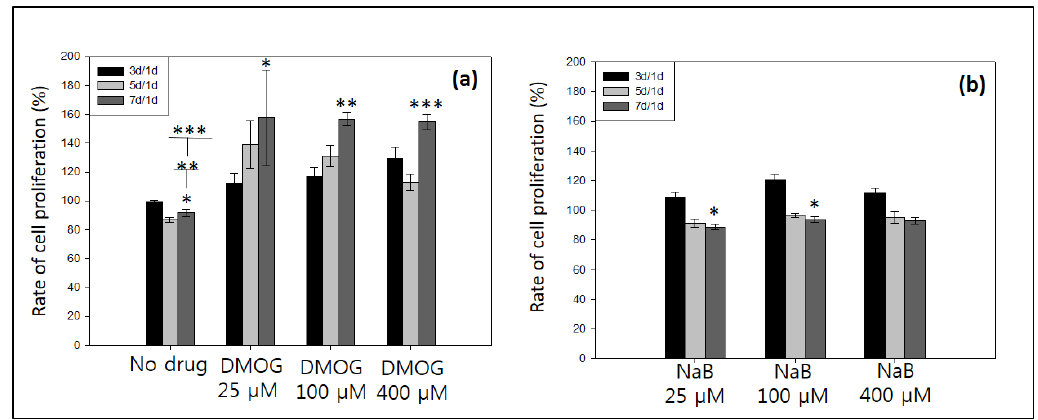
Figure 8. Cell proliferation of MC3T3 cells in absence or presence 25, 100 and 400 µ M of ( a ) DMOG, and ( b ) NaB, measured by CCK-8 assay.